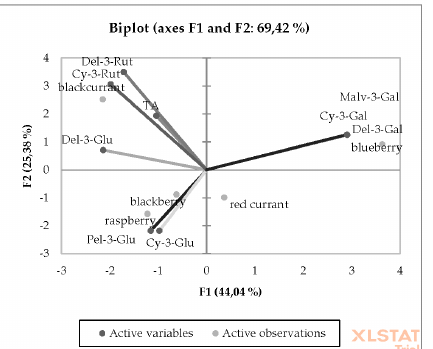
Figure 3. PCA showing the relationship between the anthocyanin content of different berry fruit species: total anthocyanins (TA), cyanidin-3-O-glucoside (Cy-3-Glu), pelargonidin-3-O-glucoside species: total anthocyanins (TA), cyanidin-3- O -glucoside (Cy-3-Glu), pelargonidin-3- O -glucoside (Pel- (Pel-3-Glu), delphinidin-3-O-glucoside (Del-3-Glu), delphinidin-3-O-rutinoside (Del-3-Rut), 3-Glu), delphinidin-3- O -glucoside (Del-3-Glu), delphinidin-3- O -rutinoside (Del-3-Rut), cyaidin-3- O - rutinoside (Cy-3-Rut), delphinidin-3- O -galactoside (Del-3-Gal), cyanidin-3- O -galactoside (Cy-3-Gal), and malvidin-3- O -galactoside (Malv-3-Gal).